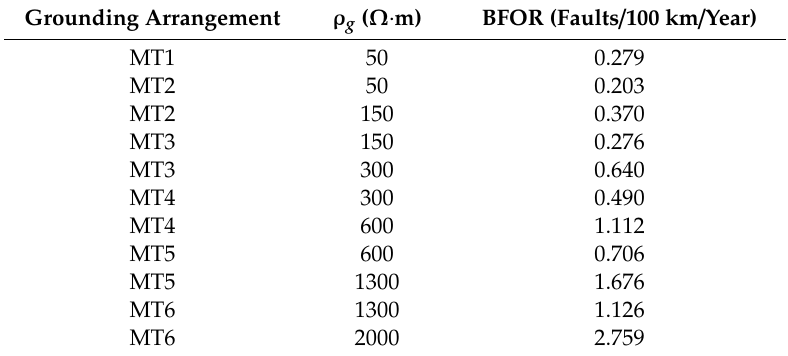
Table 16. BFOR calculated by the Monte Carlo procedure for the simulated grounding system